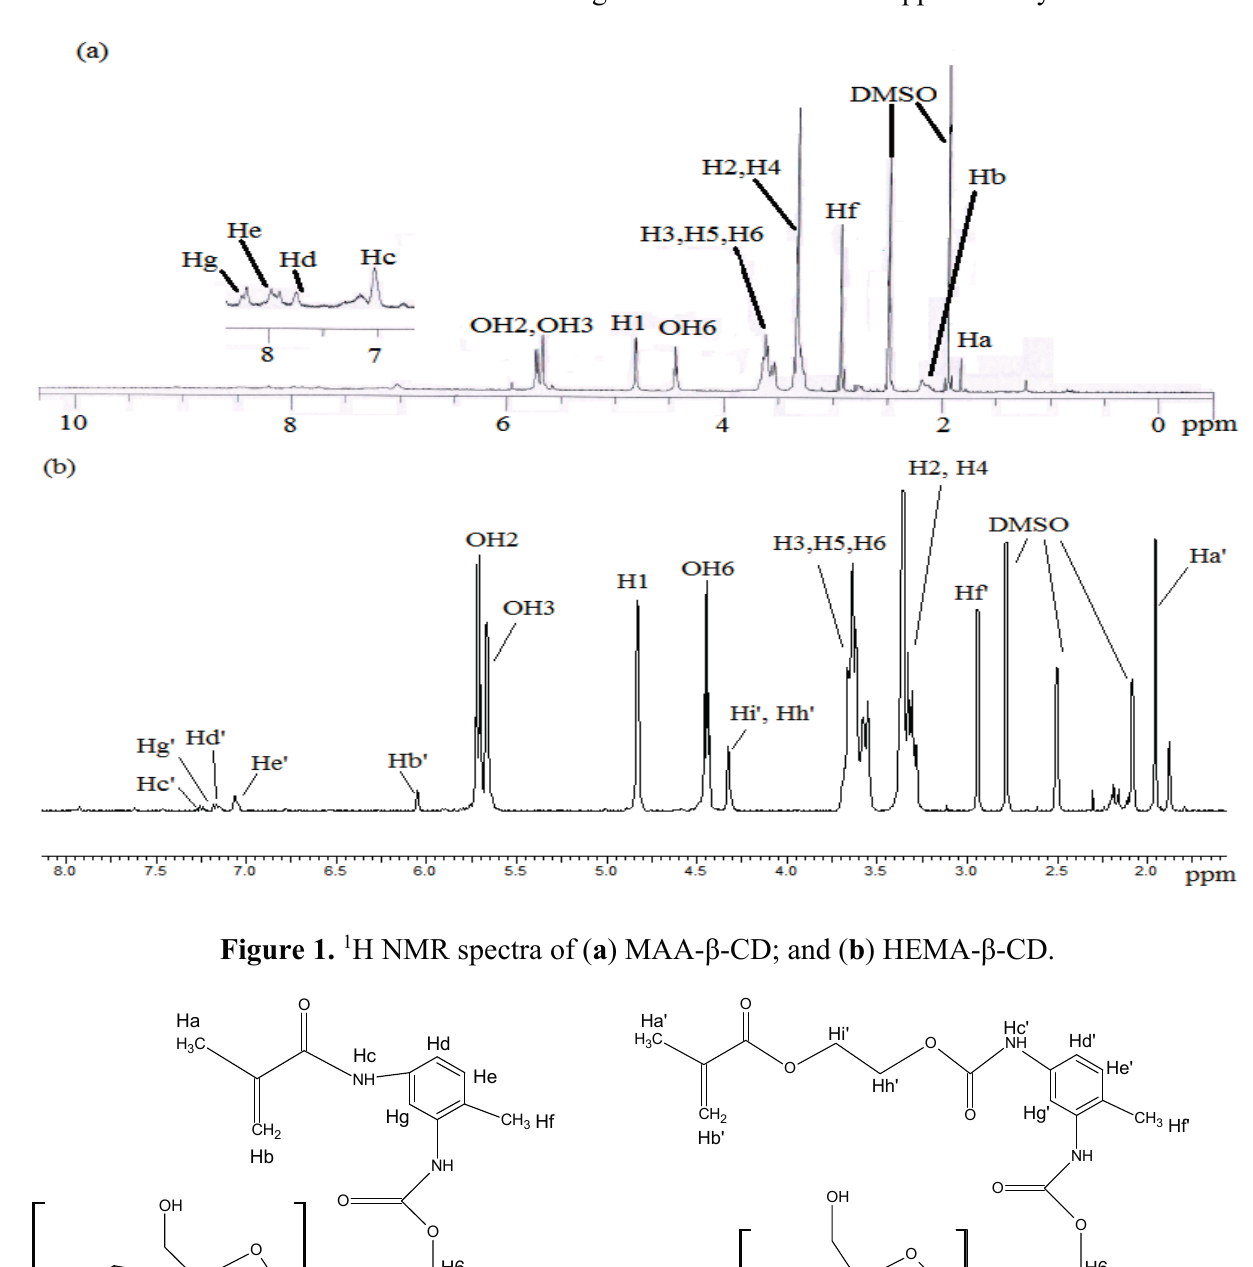
Figure 2. Structures of ( a ) MAA- β -CD; and ( b ) HEMA- β